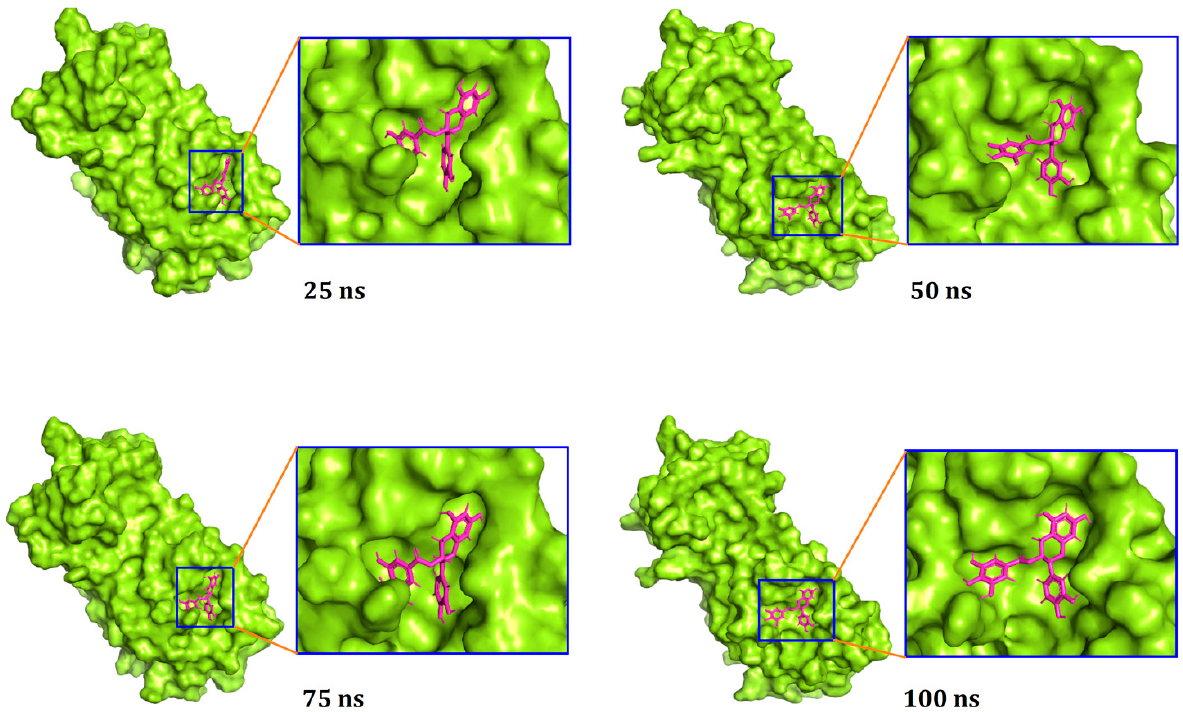
Figure 7. The surface view of the docked (-)-catechin gallate and M pro complex, with snapshots at 25, 50, 75, and 100 ns.